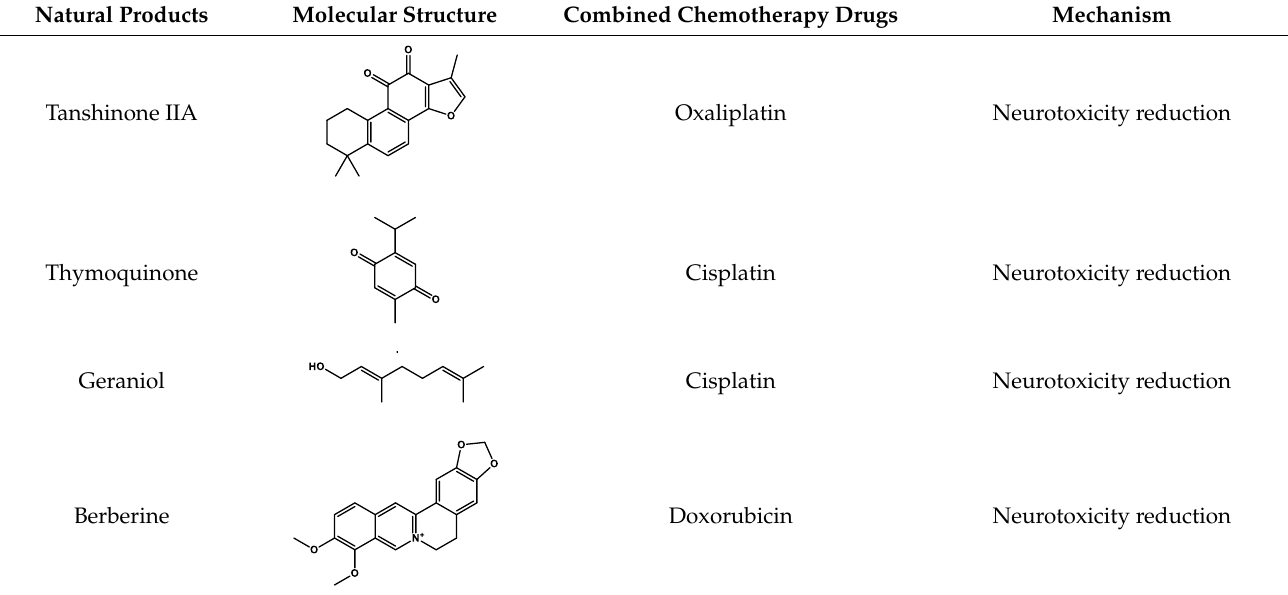
Table 3. Natural compounds that attenuate adverse effects of chemotherapy and their mechanisms.